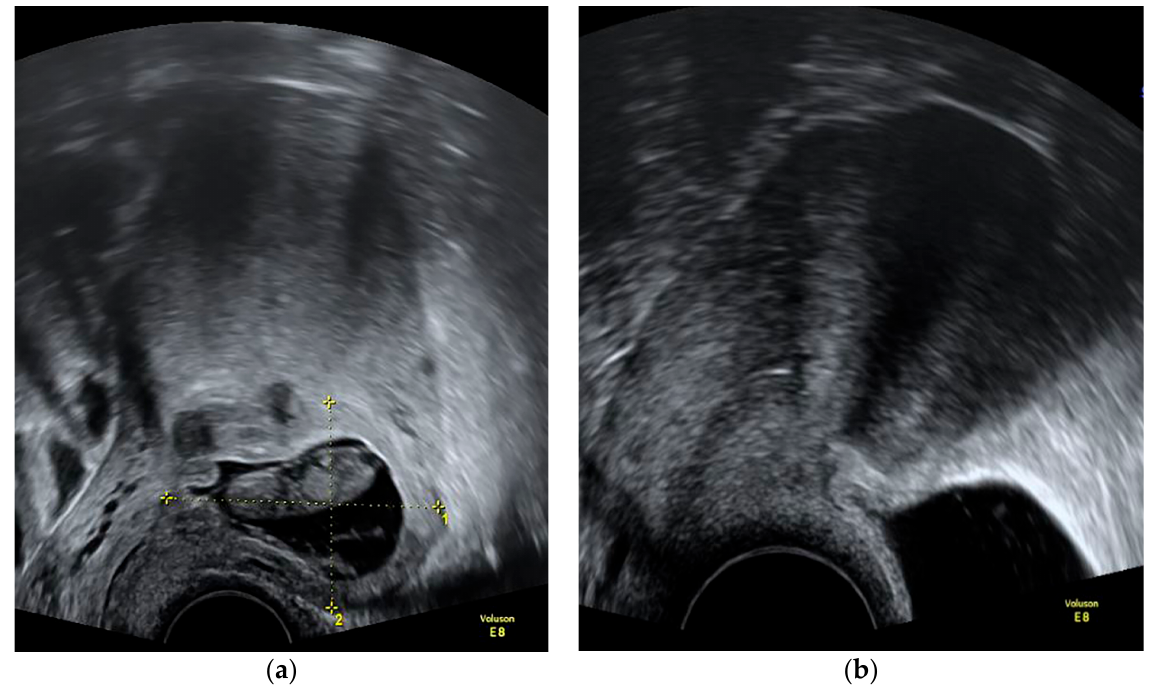
Figure 1. Ultrasound image of a cesarean scar pregnancy before and after treatment with intrachorial and intramuscular methotrexate: ( a ) at initial diagnosis (11 + 1 gestational weeks); ( b ) 4 months after treatment with methotrexate .